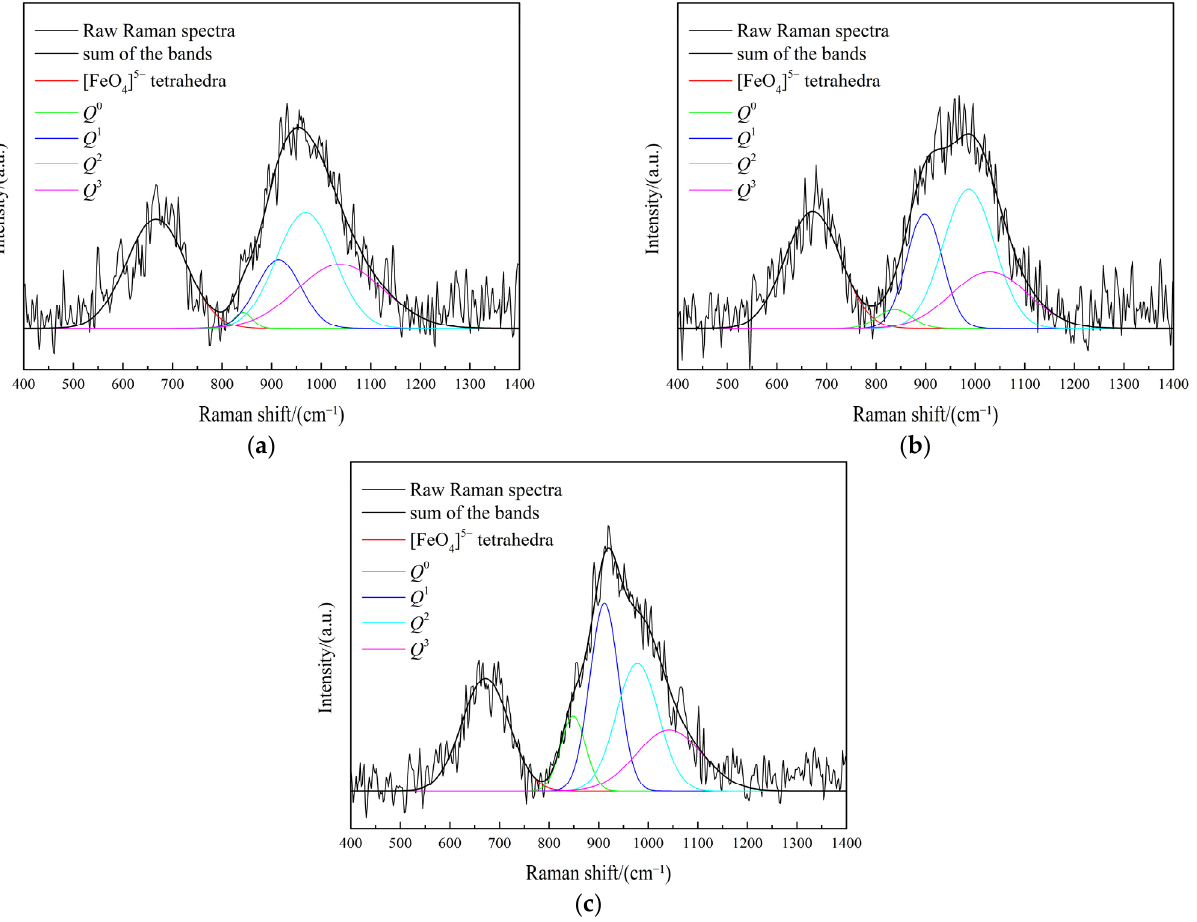
Figure 8. Deconvolution schematic of Raman spectrum of quenched samples at Fe 2 O 3 content of 8 wt% with various Fe/SiO 2 ratios of ( a ) 0.8; ( b ) 1.0 and ( c ) 1.2. Table 2. Deconvolution results of the characteristic peaks of Raman spectra of samples with varying Fe/SiO 2 ratios at Fe 2 O 3 content of 8